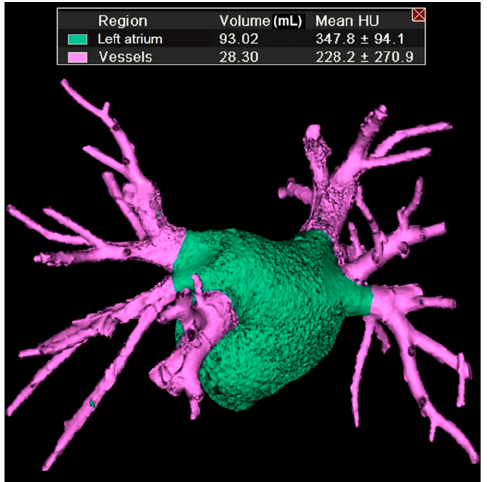
Figure 1. An example of three-dimensional measurements of the pulmonary vein volume using the dedicated image analysis software (Vitrea 2; Vital Images, Minneapolis, MN, USA) on multidetector computed tomography images. HU = hounsfield.